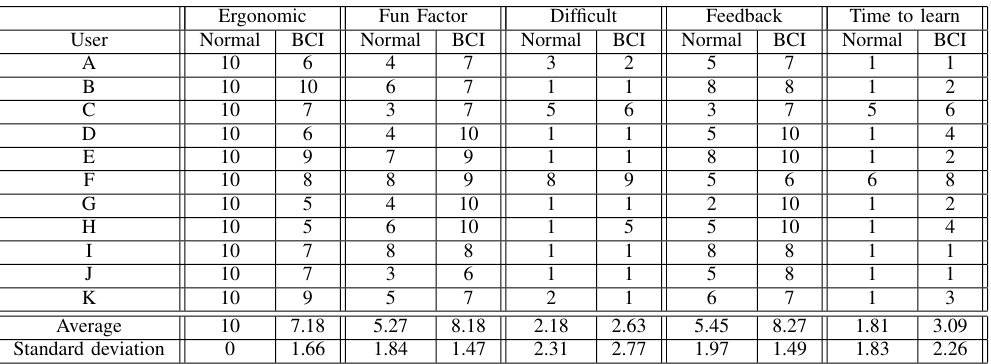
Table IV: Results of the usability tests Without the